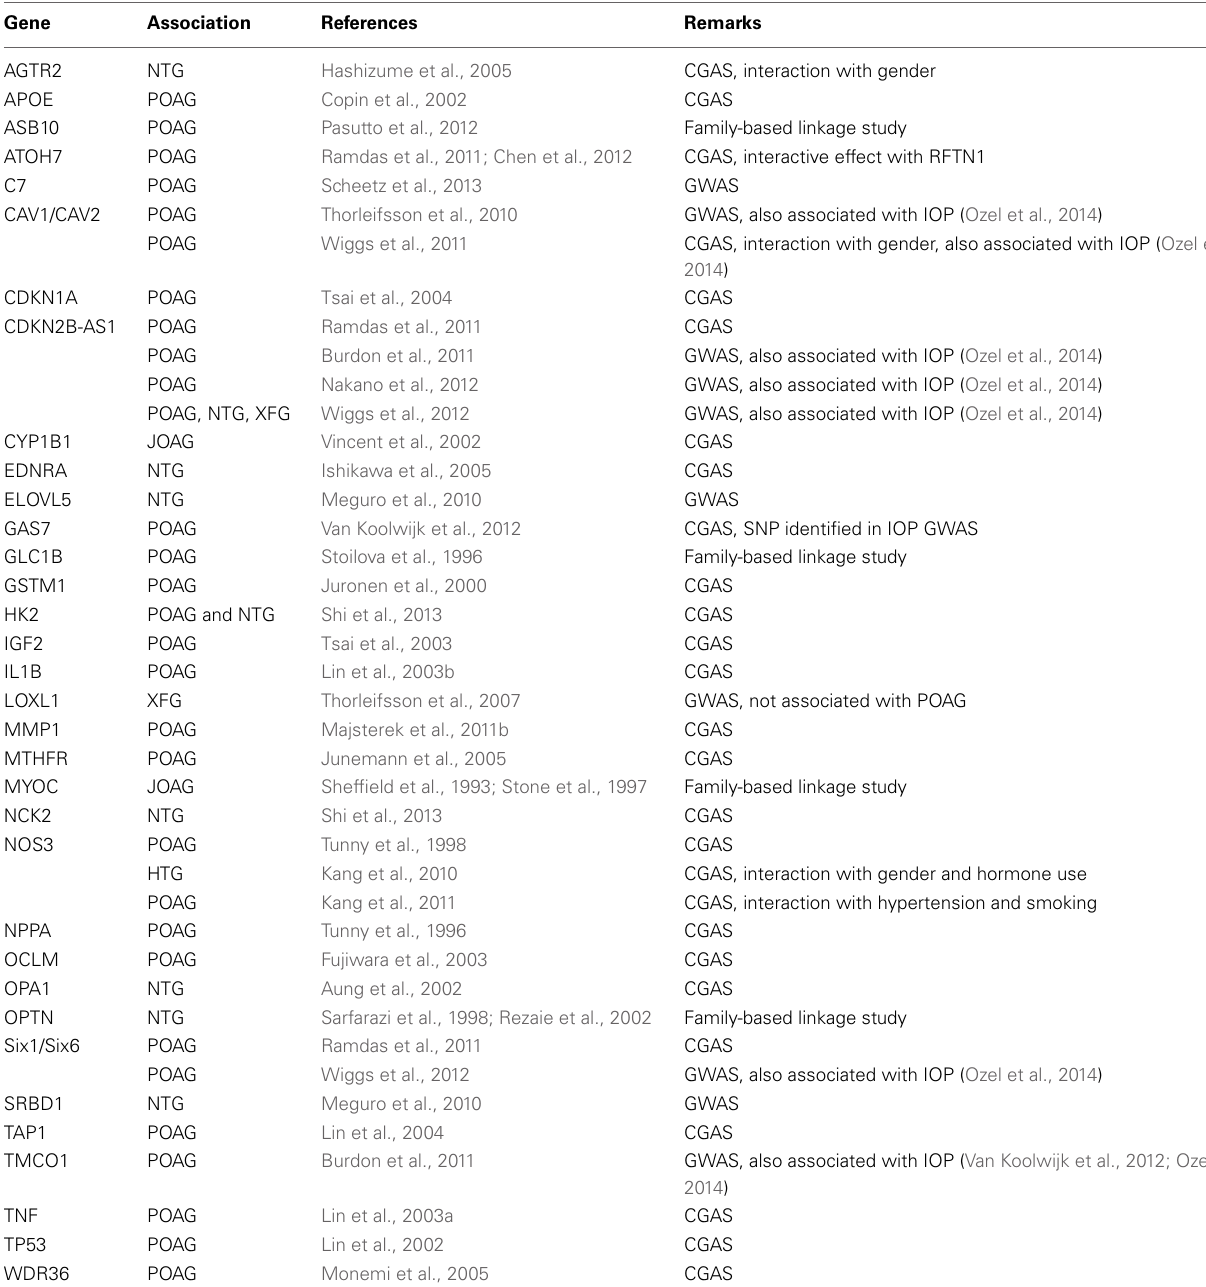
Table 2 | POAG-associated